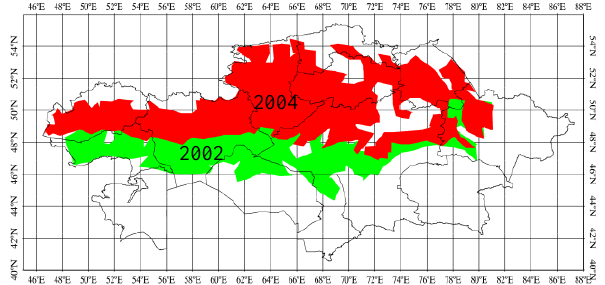
Figure 4. Locations of zone with IVInorm (0.2-0.3) in the territory of Kazakhstan for various weather conditions